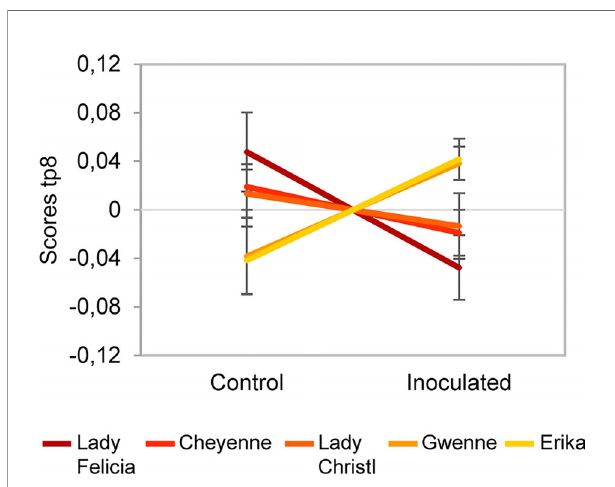
FIGURE 9 | Scores of predictive component tp8 associated with the Cultivar x Inoculation interaction effect for the negative ion mode dataset. The score value is reported on the vertical axis for control and inoculated conditions (in the horizontal axis). A difference between resistant cultivars (Erika and Gwenne) and susceptible cultivars (Lady Felicia, Cheyenne, and Lady Christl) can be